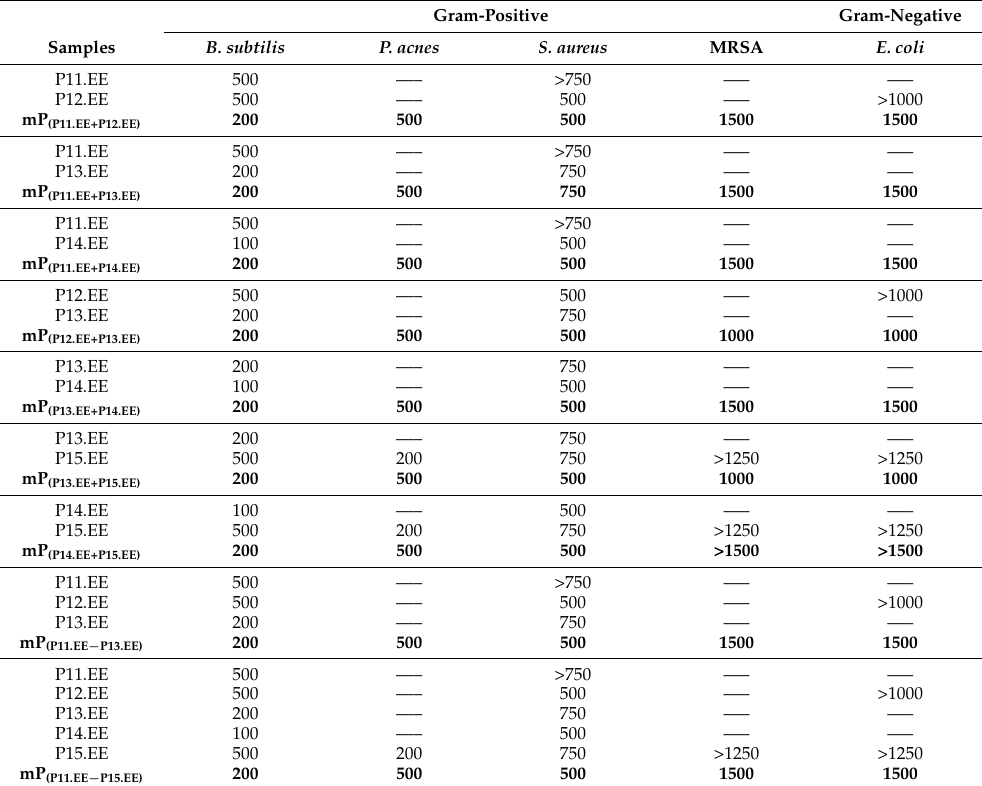
Table 3. MIC values ( µ g/mL) of the ethanol extracts of propolis from Pereiro collected from 2011 to 2015 and of the mixtures of P.EEs against Bacillus subtilis , Propionibacterium acnes , Staphylococcus aureus , methicillin-resistant Staphylococcus aureus (MRSA) and Escherichia coli . The results show the mean ± standard deviation of three assays with three replicates